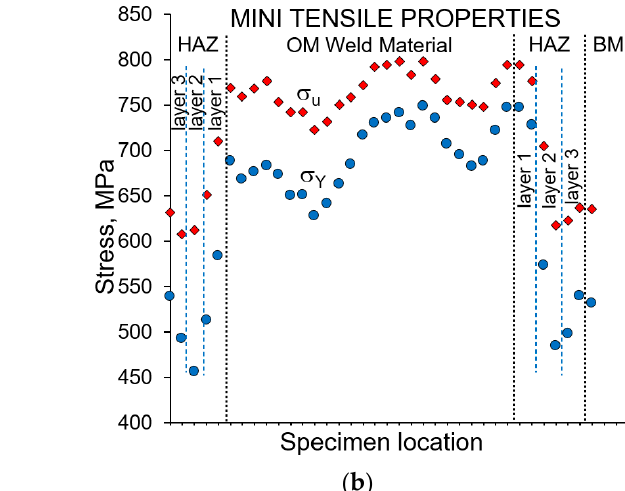
Figure 3. Results of tensile testing of both welded metals from mini tensile specimens: ( a ) under-match weld joint; ( b ) over-match weld joint.